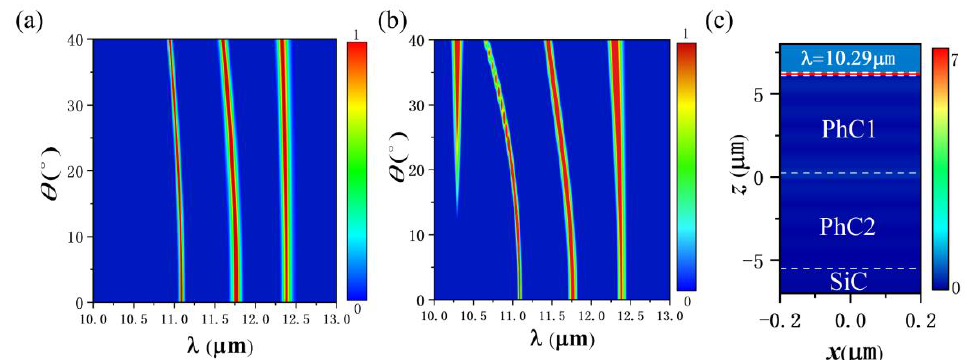
Figure 5. ( a ) The relationship between the absorption spectra and the incident angle for TE polarized light (N 1 = 3, N 2 = 3, d 0 = 0.4 µ m). ( b ) The relationship between the absorption spectra and the incident angle for TM polarized light (N 1 = 3, N 2 = 3, d 0 = 0.4 µ m). ( c ) The electric field intensity distribution at 10.29 μm.